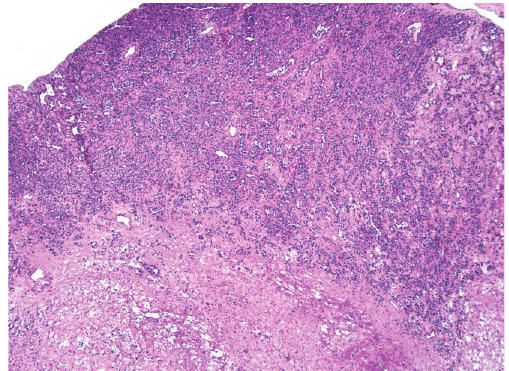
Figure 2: Low-power view of the cellular tumor forming slit-like vascular spaces, cords, and small nests. The central area is relatively hypocellular and edematous (hematoxylin & eosin, low power).